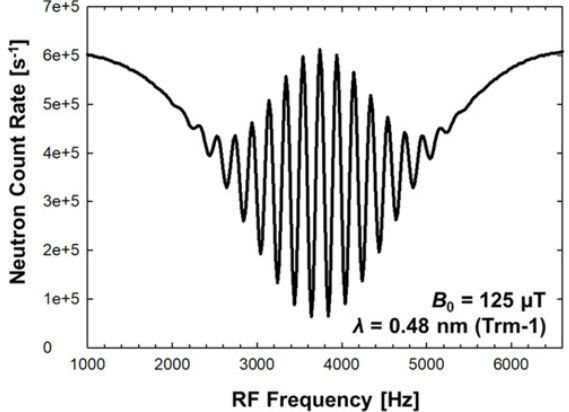
Figure 4. Ramsey resonance signal of one of the four detector beam spots (upper beam, transmission) at a wavelength selector setting of 0.48 nm with a wavelength spread of (cid:4)λ/λ ≈ 10%. The presented result is obtained by scanning the frequency of the spin flip coils close to the neutron Larmor resonance frequency. The entire curve was measured within approximately one hour (10 s per